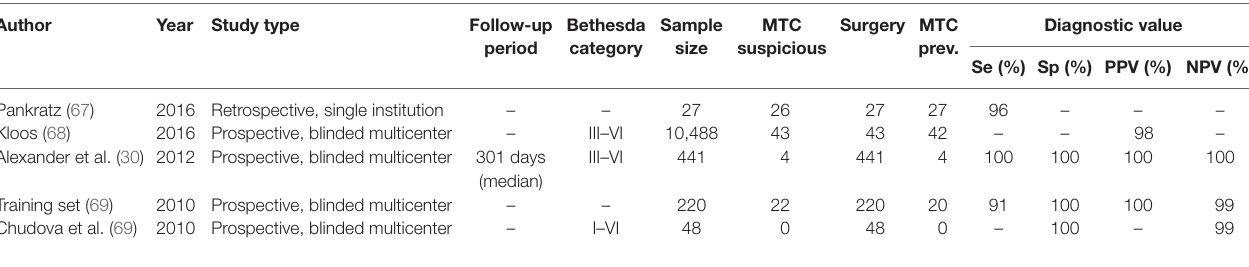
TAble 4 | Medullary thyroid cancer (MTC) classifier and diagnostic